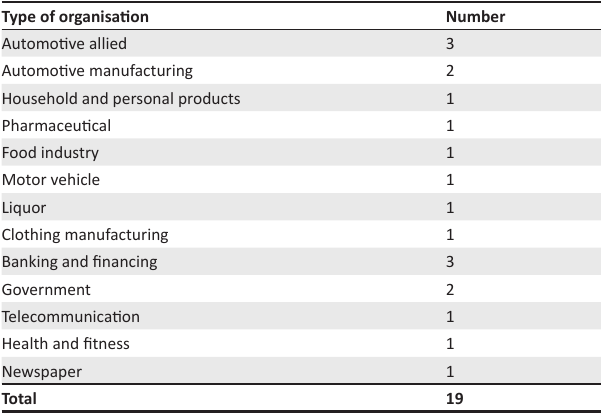
TABLE 1: Types of